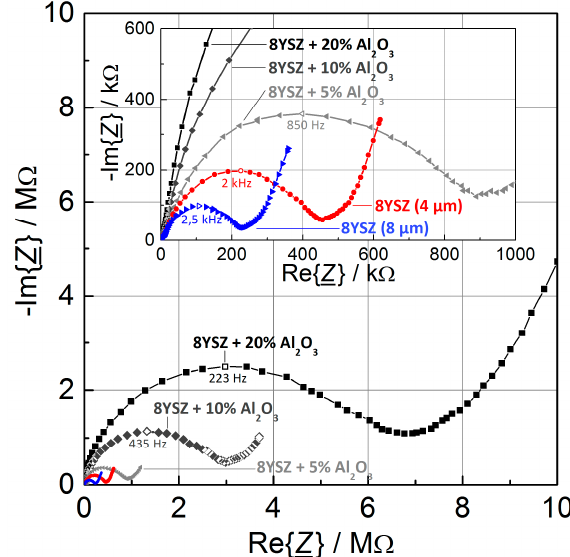
Figure 4. Impedance spectroscopy measurements of sensors with screen-printed electrolytes and overlying platinum electrodes. The composition of the electrolyte was varied from pure 8YSZ to additions of up to 20 weight % Al 2 O 3 (SP 1 to SP 5). Measurements were performed in base gas (10% O 2 and 2% H 2 O with N 2 as a balance) at 420 °C. The hollow indicator marks the top of each semicircle and the corresponding frequency.